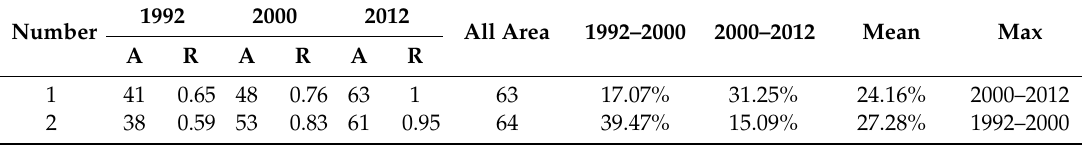
Figure 12. Results of the built-up areas within the economic corridor of Xi ‘ an. Table 5. Statistics of the built-up areas within the economic corridor for